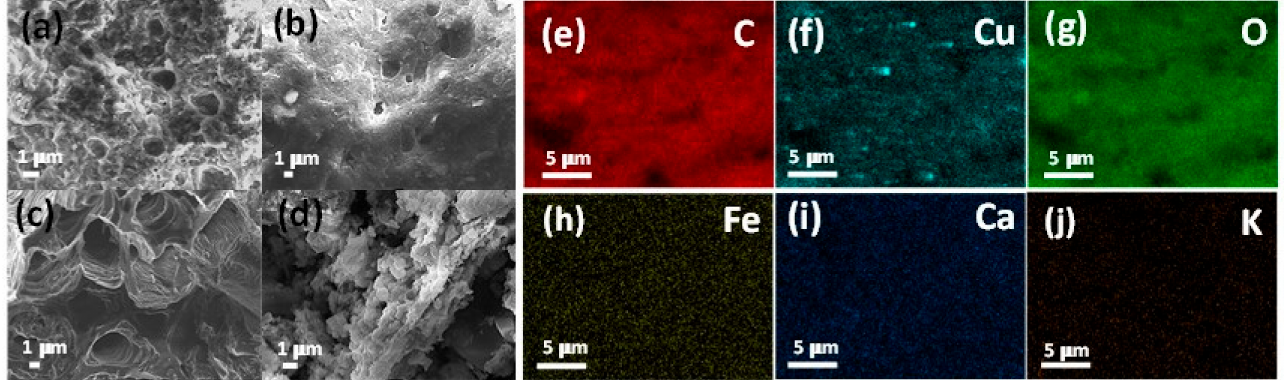
Figure 2. Scanning electron microscopy (SEM) micrographs of ( a ) Cu-Fe@OP100 ◦ C, ( b ) Cu-Fe@OP200 ◦ C, ( c ) Cu-Fe@OP300 ◦ C, and ( d ) Cu-Fe@OP400 ◦ C samples. SEM-mapping analysis of Cu-Fe@OP200 ◦ C sample for ( e ) carbon, ( f ) copper, ( g ) oxygen, ( h ) iron, ( i ) calcium, and ( j )